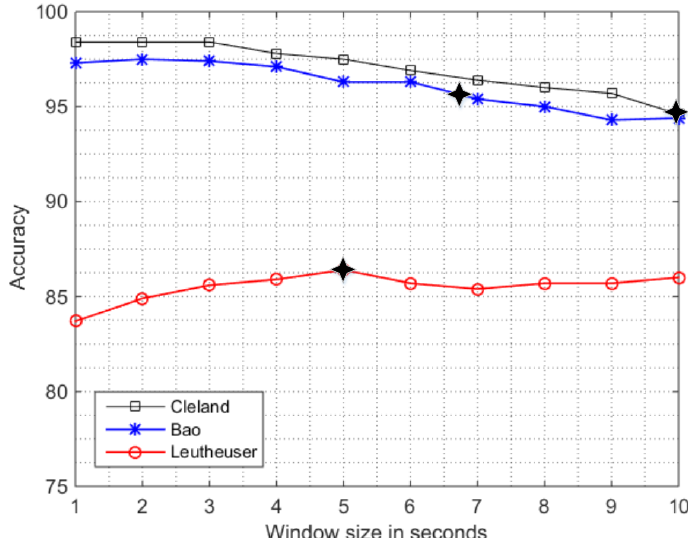
Sensors 2016 , 16 , x FOR PEER REVIEW